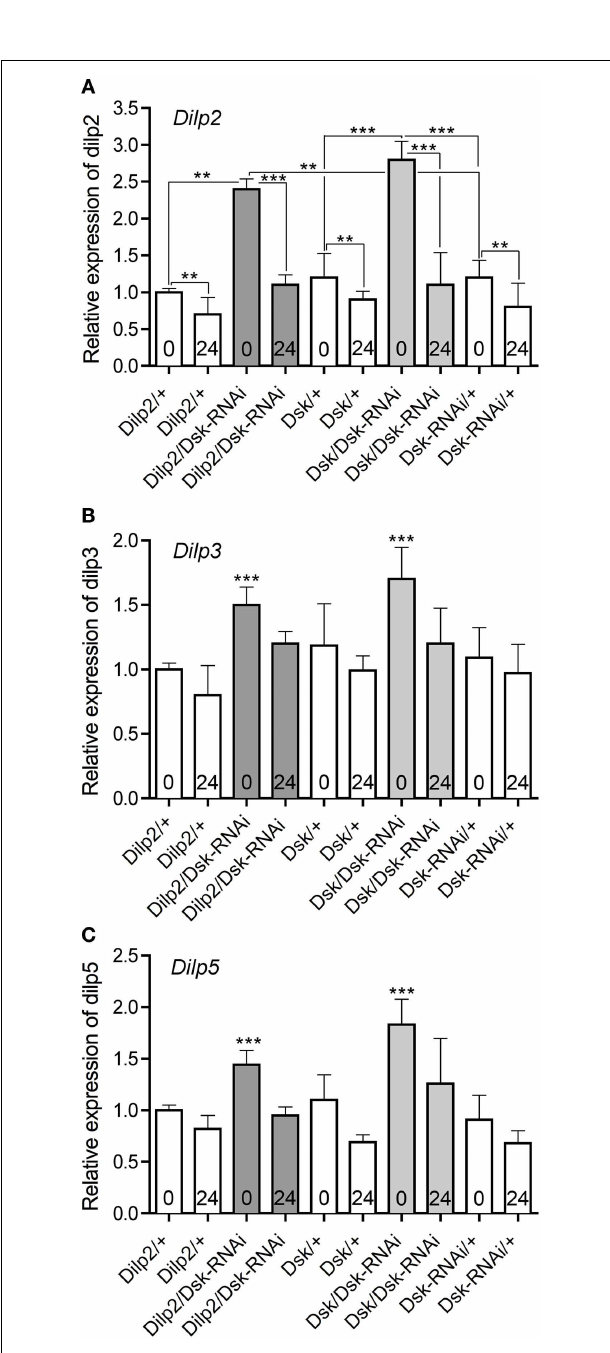
FIGURE 6 | Relative expression levels of Dilp transcripts in DSK deficient files. The effect of Dsk -knockdown in the IPCs ( Dilp2 / Dsk -RNAi; dark gray bars) and DPCs Dsk/Dsk -RNAi (light gray bars) on Dilp expression in the brain of adult flies was measured by quantitative real time PCR. Fed flies (bars indicated with 0) and flies starved for 24h (bars indicated with 24) were monitored. Control flies (Dilp2/ + , Dsk/ + , and Dsk-RNAi/ + ) are shown in white bars. Data are shown as mean relative expression ± SD ( n = 10 for each genotype; each genotype was assayed in triplicate, experiments in triplicate), asterisks denote significant difference compared to controls for fed flies only (** p < 0.01, *** p < 0.001), except in (A) where all significance comparisons are shown. Note that the levels of Dilp2, 3, and 5 diminish significantly in all genotypes after 24h starvation ( p < 0.01, One-way